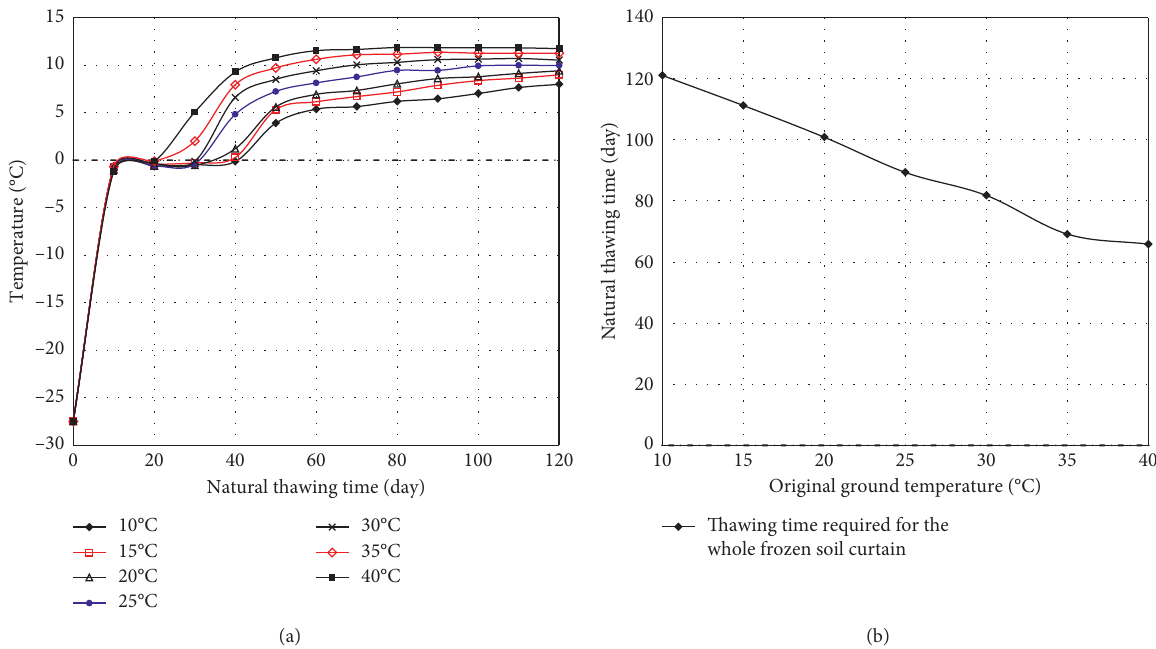
Figure 17: Effects of original ground temperature on the temperature-thawing time response and required thawing time for frozen soil curtain: (a) temperature-thawing time response at X � 3m (monitor point 2); (b) variation of required thawing time with original ground